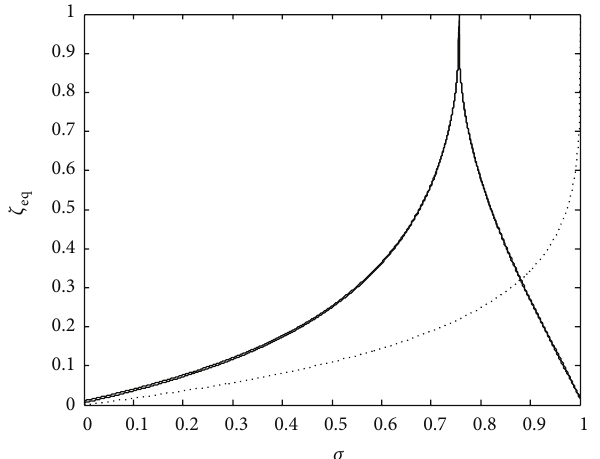
Figure 13: Equivalent damping ratio comparison between an impacting model, considering a frequency ratio of Ω = 3 (—), and thesamemodelwhenthesecondarymassapproacheszero( ⋅ ⋅ ⋅ ).The viscous damping ratio considered for both models is the same and is equal to